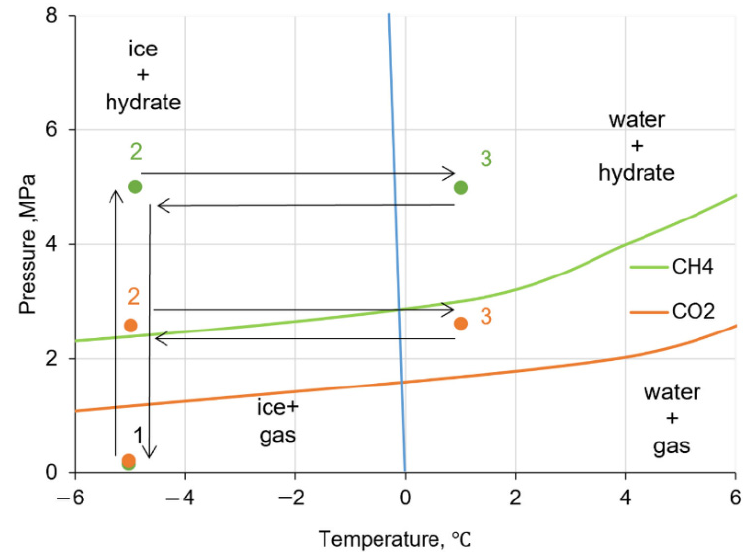
Figure 2. Phase diagrams for CH 4 and CO 2 hydrates and PT conditions of experiments: green and orange points refer to runs with CH 4 - and CO 2 -saturated sand samples, respectively. Arrows show direction of pressure and temperature changes.